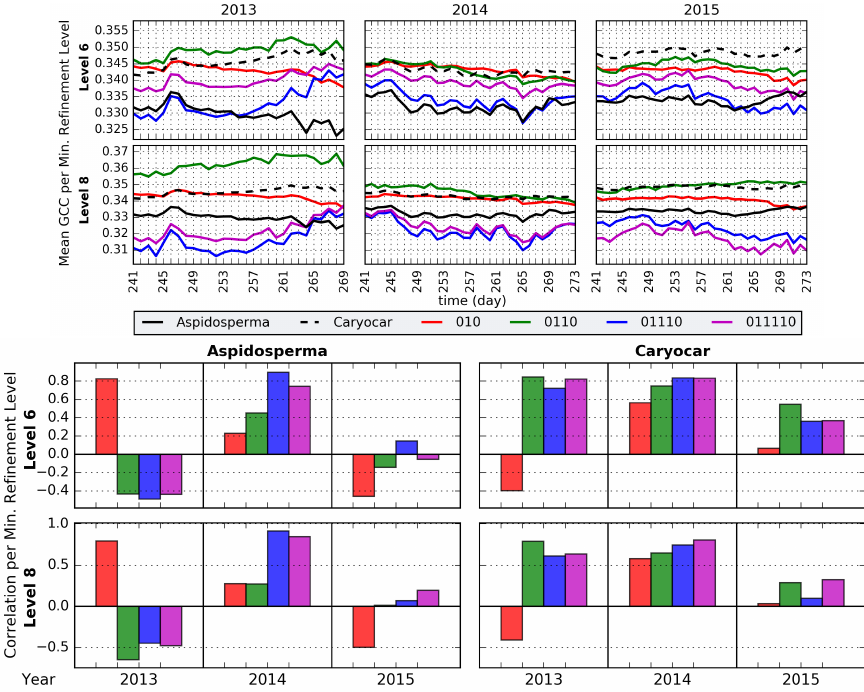
Figure 9. Mean GCC time series and correlation results for ROIs and sROIs at the 6th and 8th MRLs. Both Aspidosperma tomentosum and Caryocar brasiliensis plant species were